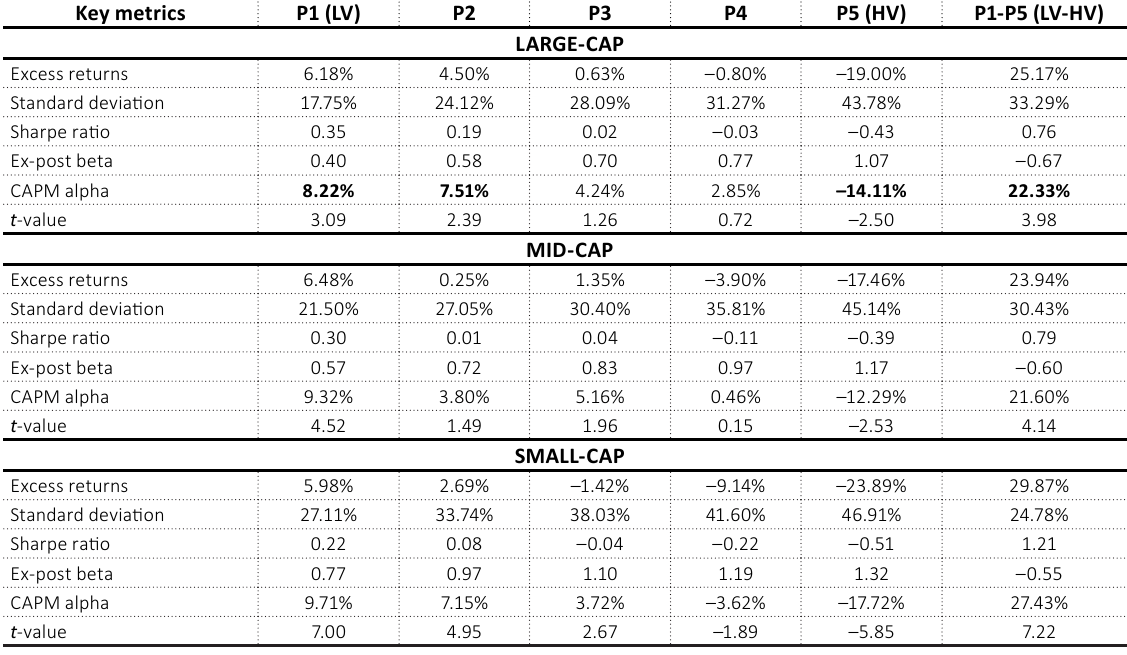
Table 15. Risk and return of large-cap, mid-cap and small-cap stocks sorted on historical volatility Key